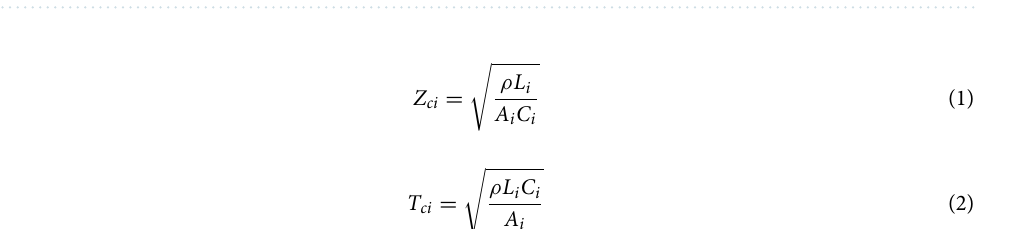
Figure 5. The cross-correlation coefficient against time